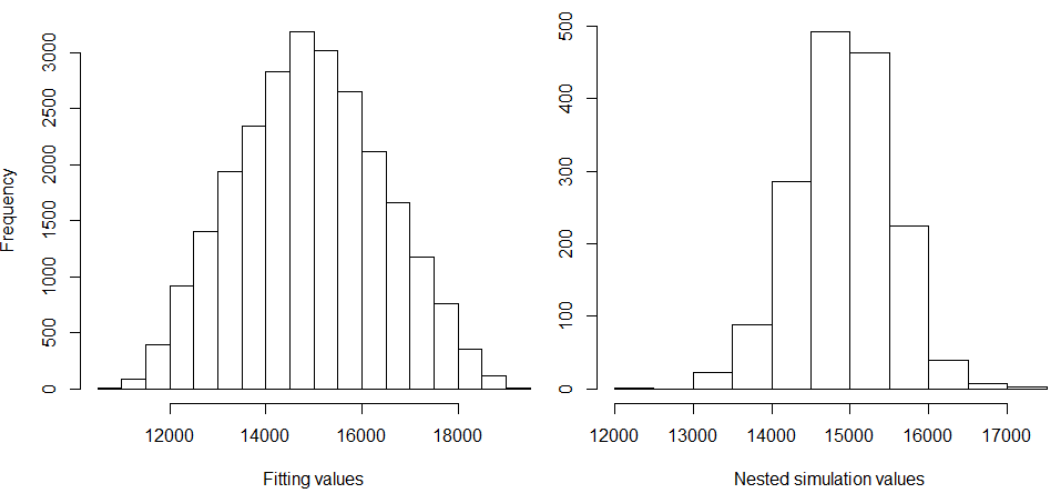
Figure 7. Histograms of fitting and nested simulation values of BEL